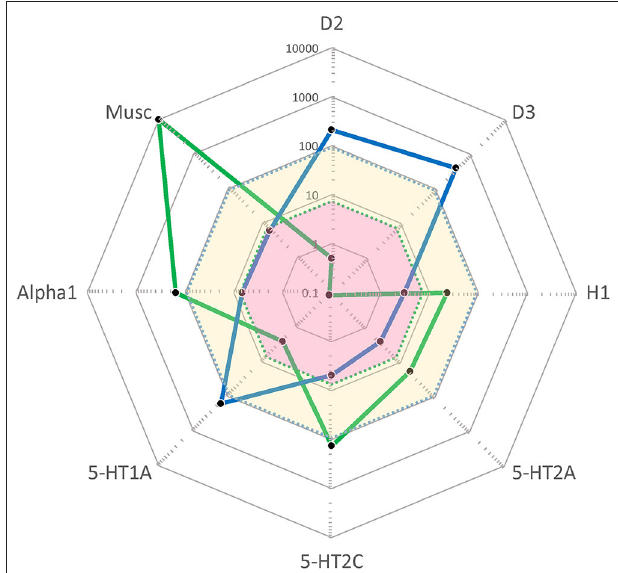
FIGURE 1 | “Cobweb” depiction of Clozapine (CLZ; blue) and Cariprazine (CAR; green) target profiles overlaid on the free (unbound) steady-state plasma concentrations (nmol/L) of these antipsychotics at average clinical dosage (CLZ: yellow area; CAR: pink area). Black dots correspond to drug affinities reported in the literature (in nM) for the targets labeled on the edges of the cobweb; the closer to the center, the higher affinity for the target in question. (For further detail, see Hjorth 16 ). D2, dopamine D2 receptor; D3, dopamine D3 receptor; H1, histamine H1 receptor; 5-HT2A, serotonin 2A receptor; 5-HT2C, serotonin 2C receptor; 5-HT1A, serotonin 1A receptor; Alpha1, α 1-adrenoceptor; Musc, ACh muscarinic